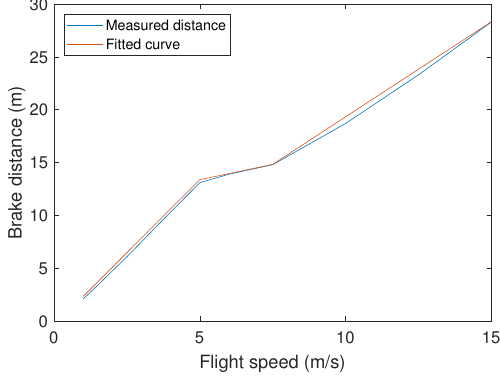
Figure 4. Measured brake distance vs. current flight